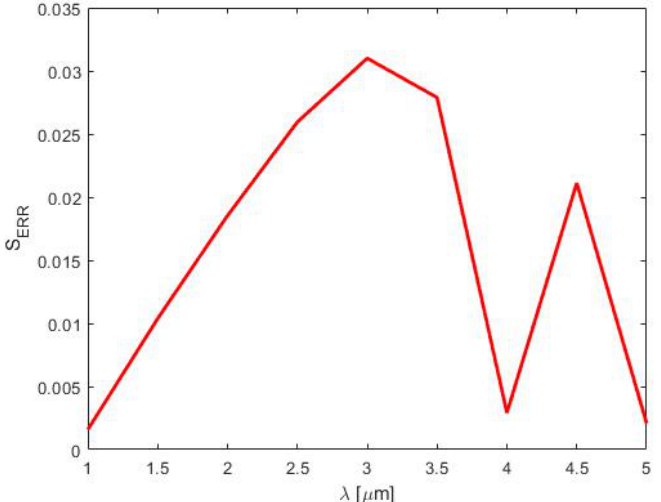
Figure A9. The difference between the spectral response with 1% error on the voltage and without it using Sinc function